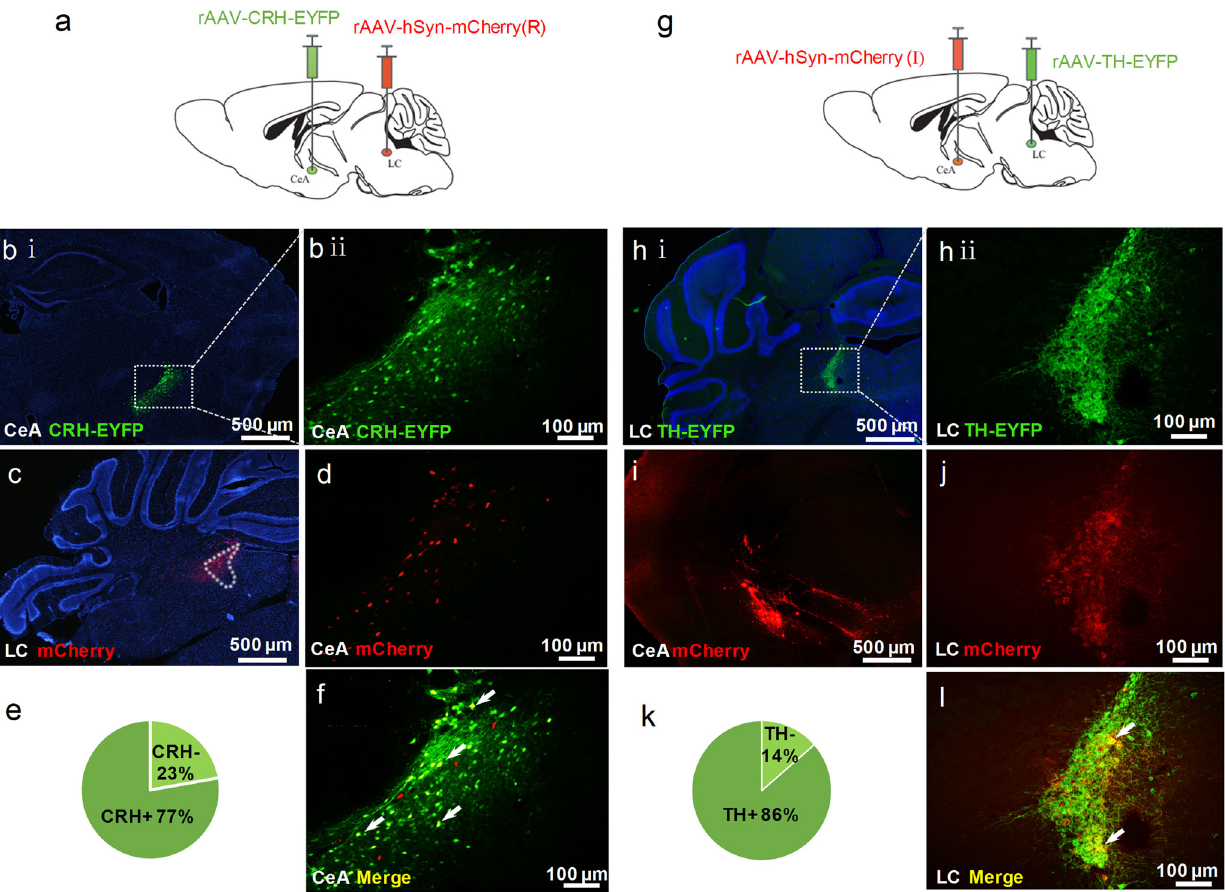
Fig. 5 CRH + neurons in the CeA predominantly project to TH + neurons in the LC. a Schematic illustration of intra-CeA injection of the rAAV-CRH-EYFP virus and intra-LC injection of the rAAV-hSyn-mCherry virus. b (i), b (ii) Intra-CeA injection of the AAV-CRH-EYFP virus induced restricted expression of EYFP (green) in the CeA. EYFP has selectively expressed in CRH + neurons. Intra-LC injection of the AAV-hSyn-mCherry virus induced expression of mCherry in the LC ( c ), and retrogradely labeled CeA-LC projection neurons in the CeA ( d ). e The proportion of CRH + (77%) in mCherry-retrogradely labeled CeA-LC projection neurons. f EYFP (green) and mCherry (red) double-labeled neurons in the CeA were indicated by white arrows and were CRH + CeA neurons projecting to the LC. g Schematic illustration of intra-CeA injection of the rAAV-hSyn-mCherry virus and intra-LC injection of the rAAV-TH-EYFP virus. h (i) -h (ii) Intra-LC injection of the AAV-TH-EYFP virus-induced restricted expression of EYFP (green) in the LC. EYFP has selectively expressed in TH + neurons. Intra-CeA injection of the AAV-hSyn-mCherry virus-induced expression of mCherry in the CeA ( i ), and anterogradely labeled neurons in the LC ( j ). k The proportion of TH + (86%) cells in mCherry-anterogradely labeled LC neurons, which receive projections from the CeA. l EYFP (green) and mCherry (red) double-labeled neurons in the LC were indicated by white arrows and were TH + LC neurons receiving projections from the